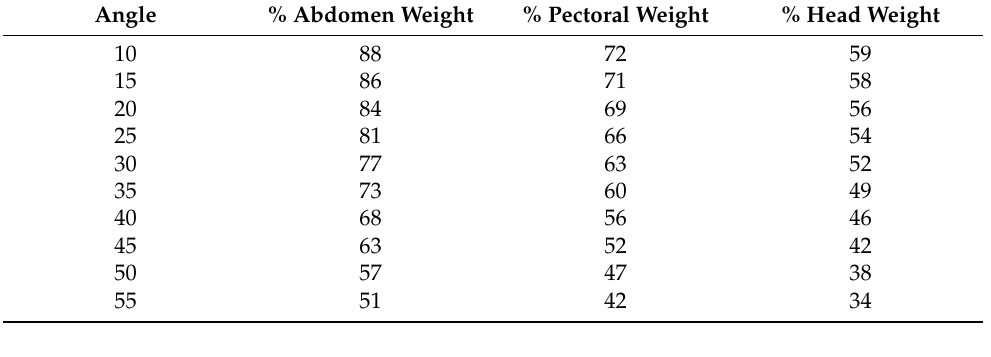
Table 1. Weight distribution according to working angles and grip positions. Data are for the same subject of mass 60 kg and 1.60 m in height, and expressed as the percentage of body weight mobilized in each repetition.